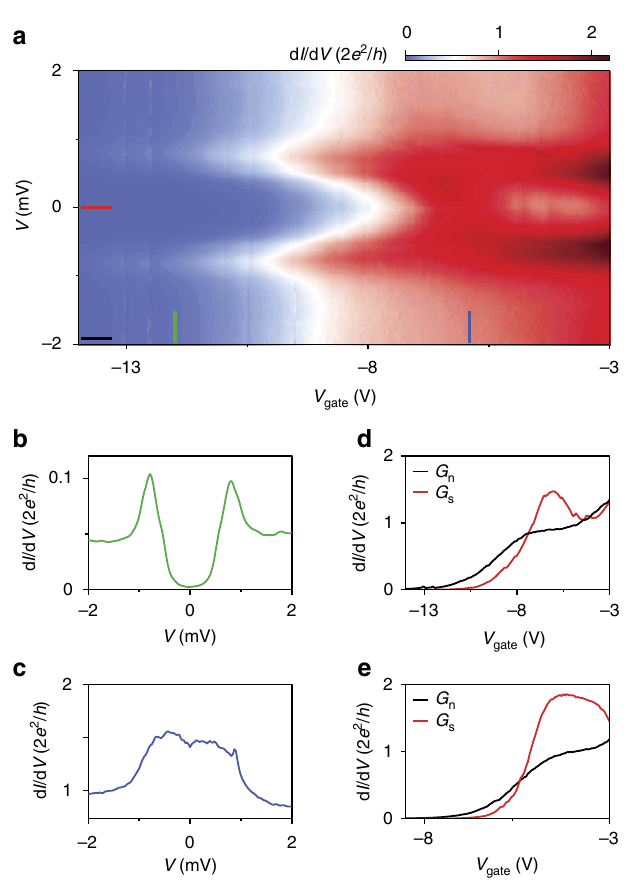
Figure 2 | Ballistic transport at zero magnetic field. ( a ) Differential conductance, d I /d V , as a function of bias voltage, V , and gate voltage, V gate for device B. ( b ) Vertical line cut from a in tunnelling regime (green trace, gate voltage ¼ (cid:3) 12V). ( c ) Vertical line cut from a on the conductance plateau (blue trace, gate voltage ¼ (cid:3) 5.9V). ( d ) Horizontal line cuts from a showing above-gap ( G n , black, | V | ¼ 2mV) and subgap ( G s , red, V ¼ 0mV) conductance. ( e ) Above-gap (black) and subgap (red) conductance for device C, where G s enhancement reaches 1.9 (cid:2) 2 e 2 / h